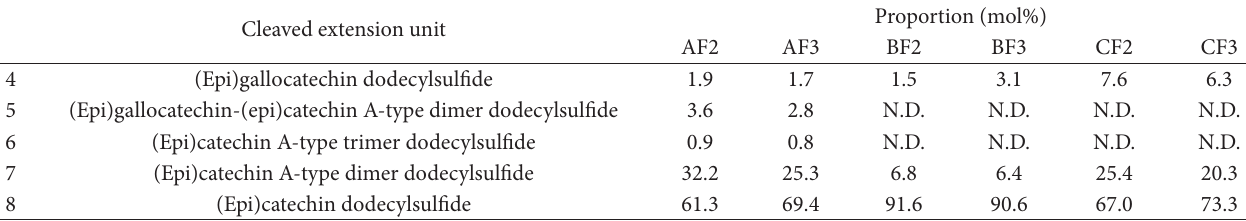
T 3: Proportions of extension units in highly polymeric proanthocyanidins from seed shells of Japanese horse chestnut, blueberry, and cranberry as determined by �P�C-��I��� of the dodecylsul�de derivatives a�er thiolytic cleavage.